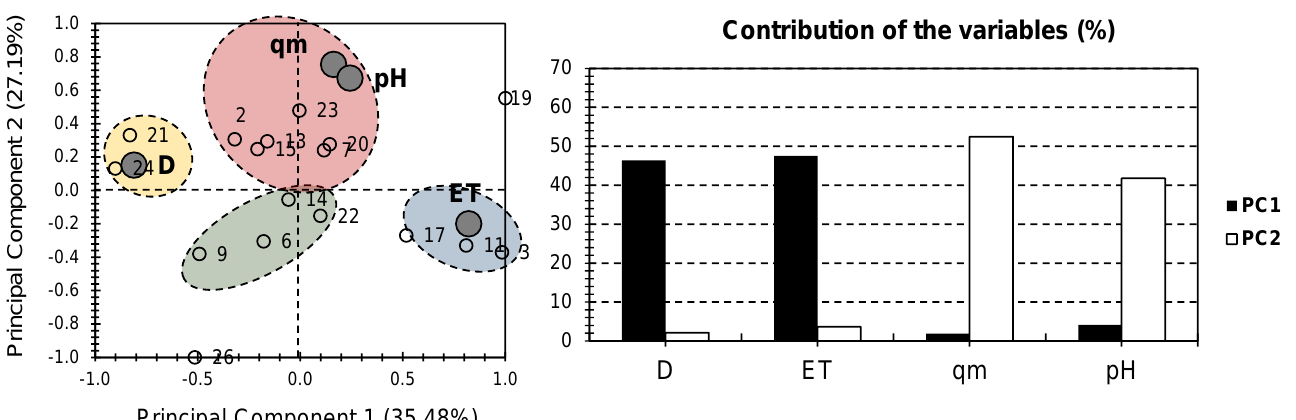
Figure 3. PCA for all datasets. Small bullets represent the 15 investigated hydrogels containing MONPs (red cluster components of Figure 2). Large gray bullets represent different physical and chemical properties, with the exclusion of metallic oxide nanoparticles (MONP%). For individuals, four different clusters were distinguished. The red cluster contained samples 2, 7, 13, 15, 20, and 23 and showed a positive correlation along qm and pH factors. The blue cluster contained samples 3, 11, and 17 and showed a positive correlation along the ET. The yellow cluster only contained samples 21 and 24 and showed a positive correlation with factor D. As for the green cluster, it contained samples 6, 9, 14, and 22 and showed a negative correlation along all of the investigated factors. Even though the red cluster PCA presented a lower variance than the “all dataset” approach, it similarly showed a higher distribution of the factors along the first two PCs, and it distinctively showed a high distribution of the individuals (four clusters in Figure 3, rather than three clusters in Figure 2). This allows for a better distinction between the different features and conditions of the different investigated hydrogel composites.